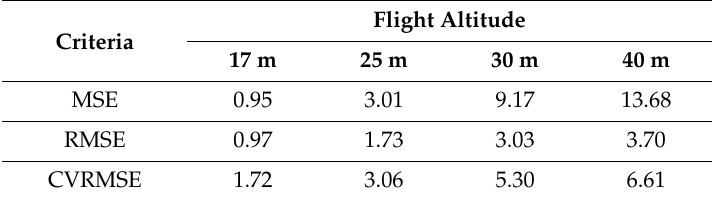
Table 5. Accuracy indicators of scenario